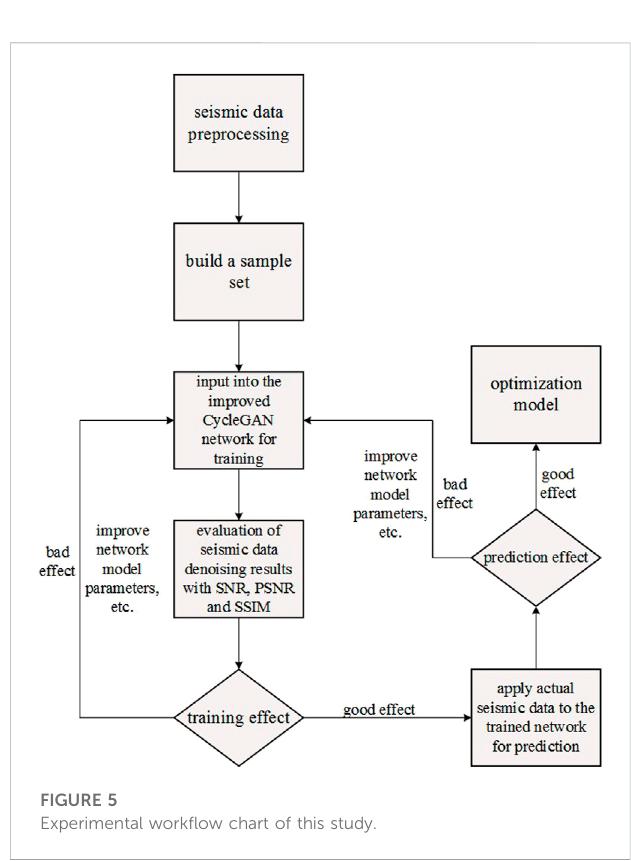
FIGURE 5 Experimental work fl ow chart of this